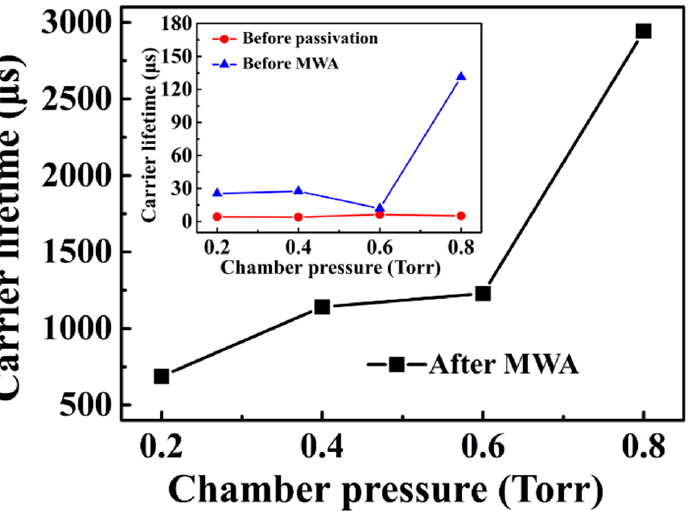
Figure 9. Optical bandgap of the thin film ( a ) before using microwave annealing and ( b ) after microwave annealing at different chamber pressures. in all cases, the MWA power was 440 W, the annealing temperature was 180 °C, and the MWA time was 20 min.